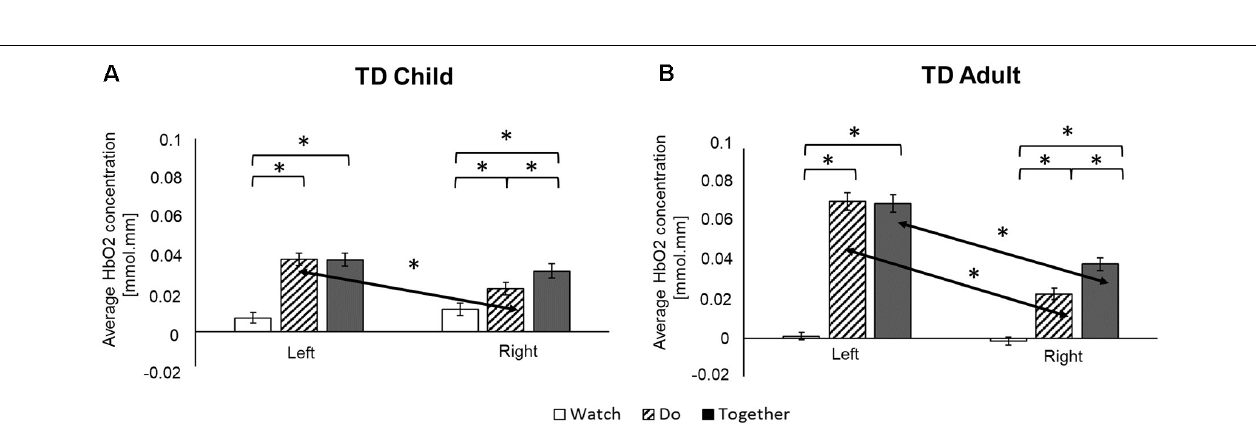
FIGURE 4 | Regional differences ( A : Watch; B : Do; C : Together) in average HbO 2 concentration. ∗ Indicates a significant difference between regions.